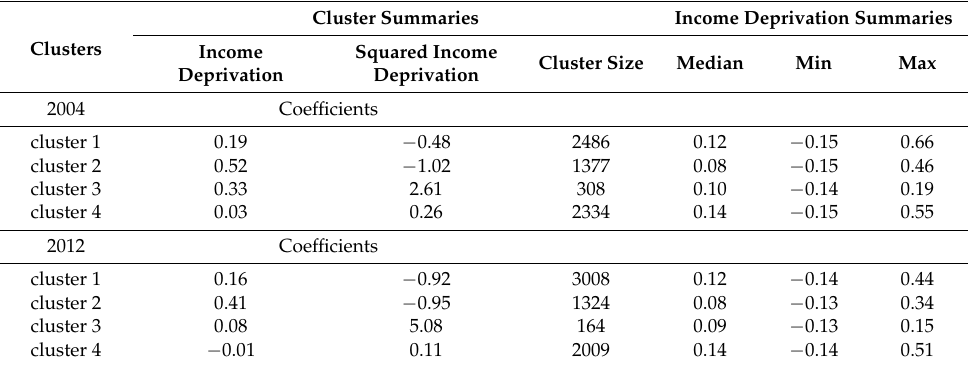
Table 5. Descriptive summaries for each cluster in 2004 and